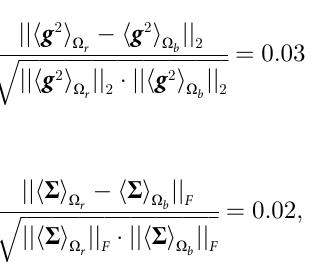
S1 Fig. Examples of expression levels of CD4, LAG3, B7H4 and CD20 before and after a median filter. (A): images from Dataset 1 with no filter (top) and after application of median filter (bottom). (B): same as (A) but for Dataset